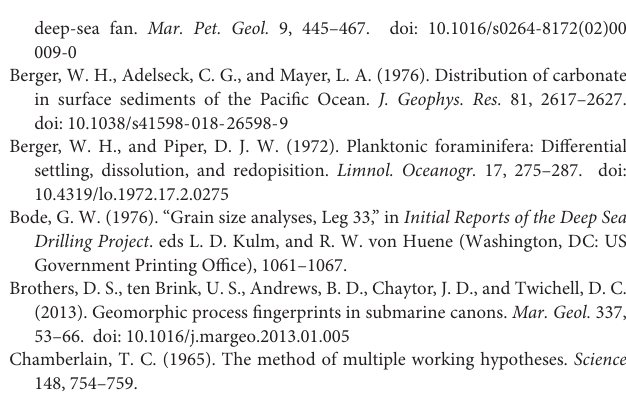
FIGURE S1 | Map of multibeam cruise data used to construct the bathymetry digital terrain model and backscatter image. Figure S2 | All of the channels of the NLIR shown on Figure 3 with no interpretation of channels. Channel drainage areas are outlined in white lines, dashed where inferred, and are labeled in white capital letters. FIGURE S3 | Map view of multibeam bathymetry of channel system CS-A shown in Figure 4A with no interpretation. FIGURE S4 | Map views of multibeam bathymetry of channel system CS-B shown in Figure 9A with no interpretation. FIGURE S5 | Subbottom seismic survey lines across channel systems CS-B and CS-C. FIGURE S6 | (A) Locations of 5-km cross-channel profiles of main channel of CS-B and CS-C. (B) Cross-channel profiles of main channel of CS-B and CS-C. Figure S7 | Map view of multibeam bathymetry of channel system CS-C shown in Figure 10A with no interpretation. FIGURE S8 | Map view of multibeam bathymetry of channel system CS-D shown in Figure 11A with no interpretation. FIGURE S9 | (A) Locations of 5-km cross-channel profiles of main channel of CS-D and CS-E. (B) Cross-channel profiles of main channel of CS-D and CS-E. FIGURE S10 | Map view of multibeam bathymetry of channel systems CS-E and CS-F shown in Figure 12A with no interpretations. FIGURE S11 | (A) Locations of 5-km cross-channel profiles of main channel of CS-F 1 and CS-F 2 . (B) Cross-channel profiles of main channel of CS-F 1 and CS-F 2